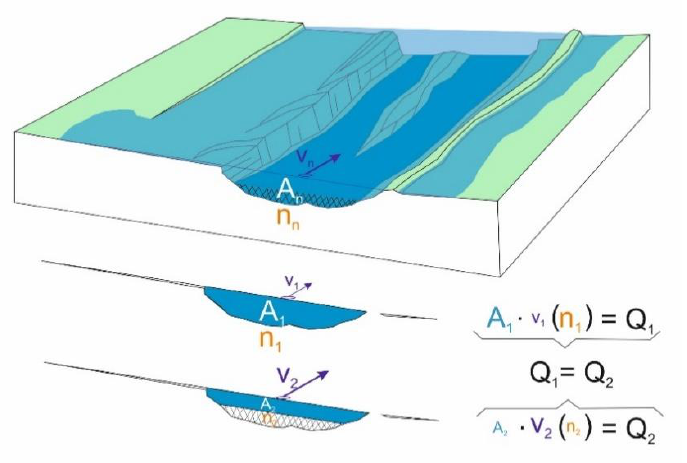
Figure 3. Basic conceptual diagram for the calibration of the parameter n, assuming that the flow rate (Q) is a function of the cross-sectional area of the channel (A 1 and A 2 ) and the mean flow velocity (V 1 and V 2 , which, in turn, is dependent on the Manning ’ s n values (n 1 and n 2 )). The size of the symbols identifying the variables is directly related to the magnitude of the